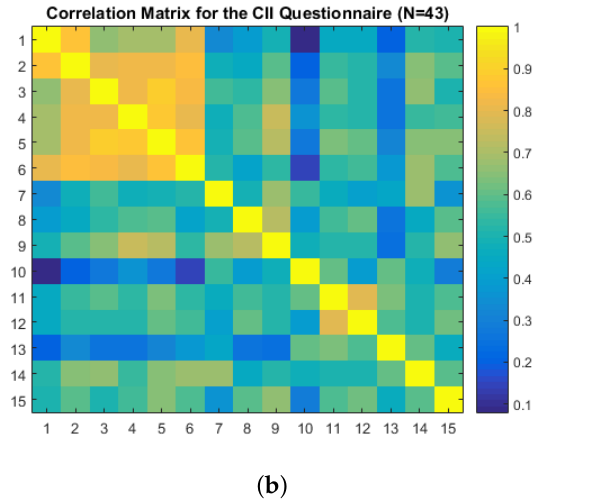
Figure 16. Heat-map plots of the correlation matrix from the independent (CII-N124) and the intersection (CII-N43) results. ( a ) A heat-map plot of the correlation matrix for the CII questionnaire with N = 124. ( b ) A heat-map plot of the correlation matrix for the CII questionnaire with N = 43.